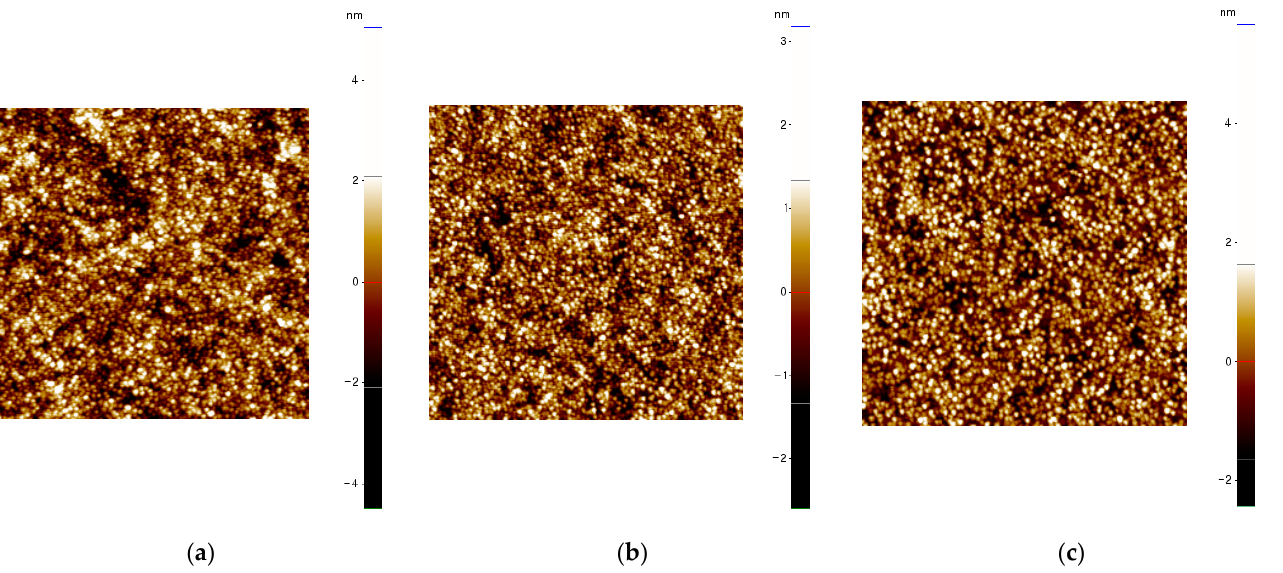
Figure 2. Surface roughness of SnO 2 as measured by AFM. The thin films were cured at ( a ) 200, ( b ) 280, and ( c ) 350 °C. The color scale is given on the right hand side of each figure.